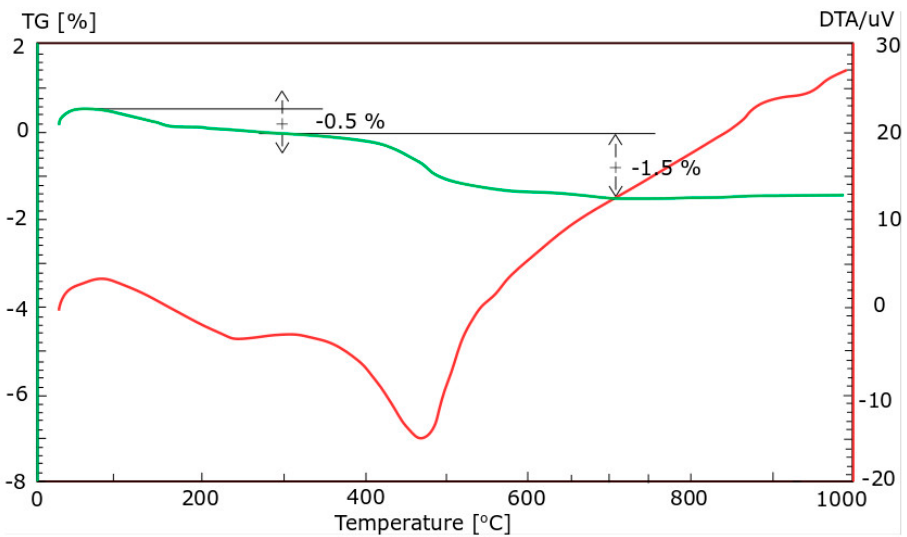
Figure 3. The differential thermal analysis (DTA) pattern of CFA batch B.